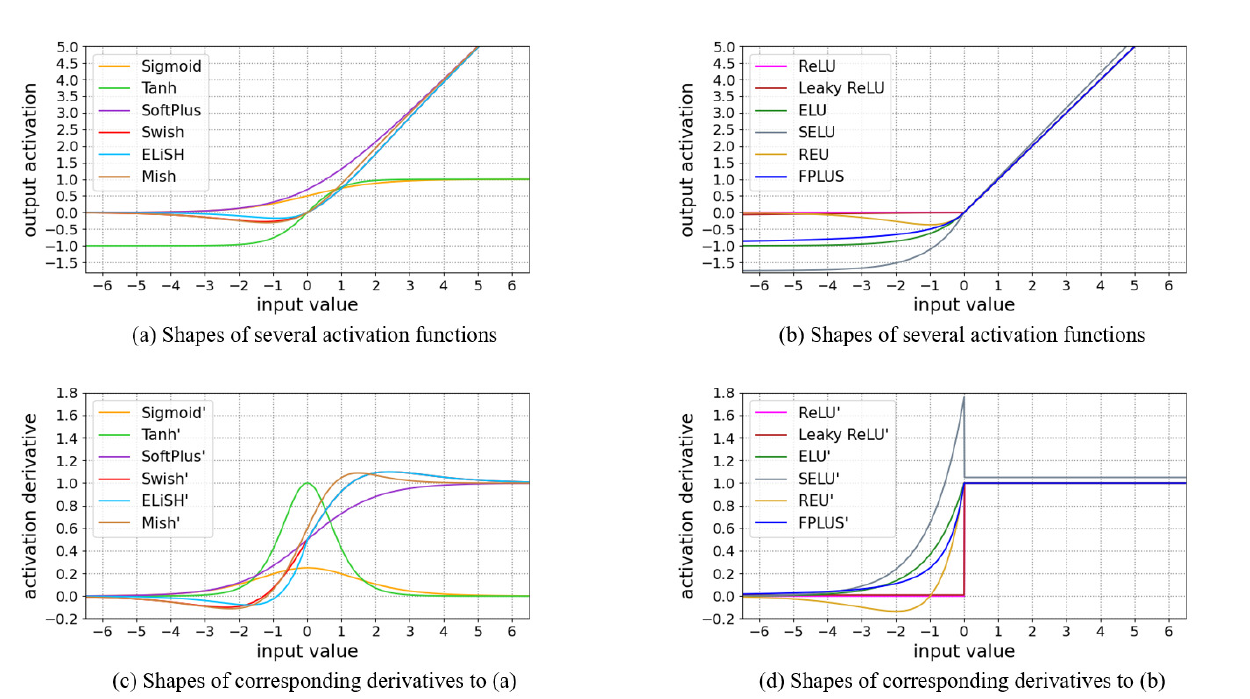
Figure 1. Shapes of typical activation functions and their corresponding